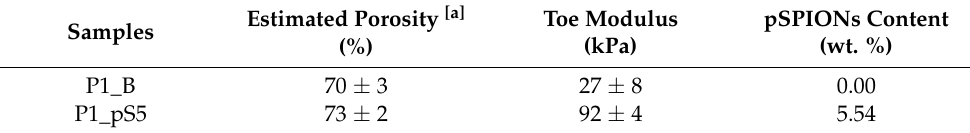
Table 4. Porosity and toe modulus of the tested